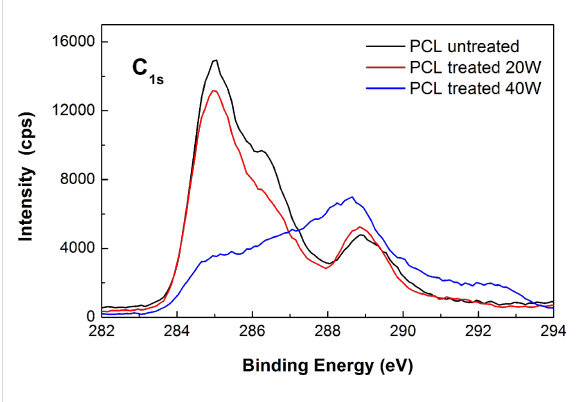
Figure 2: XPS spectra of the untreated PCL electrospun scaffolds and the O 2 -plasma modified ones, with P = 20 W and P = 40 W.